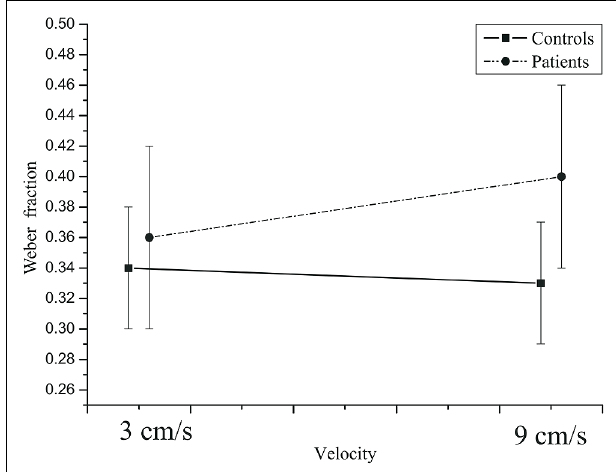
FIGURE 9 | MeanWeber fractions as a function of velocity in controls and patients. Error bars: 95% CIs.